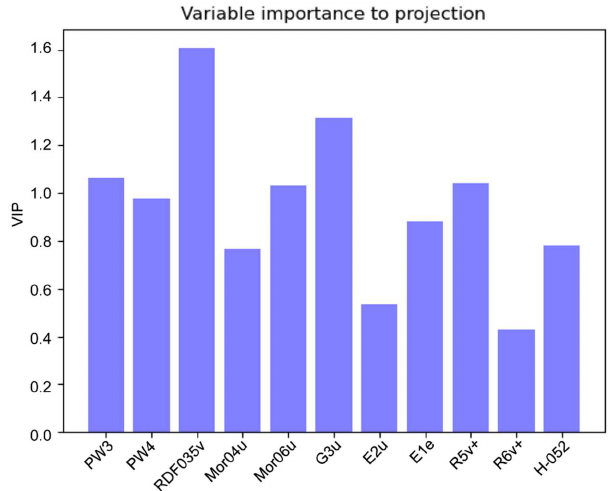
Figure 3. Variable importance to projection (VIP) plot for the DE-PLS model.